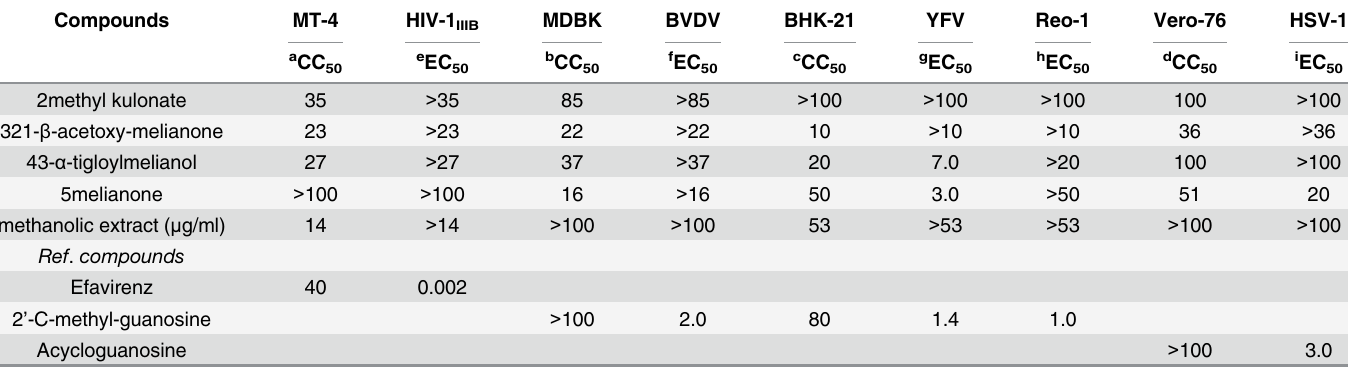
Table 1. Cytotoxicity and antiviral activity of triterpenoids from fruits of M . azedarach . Compounds